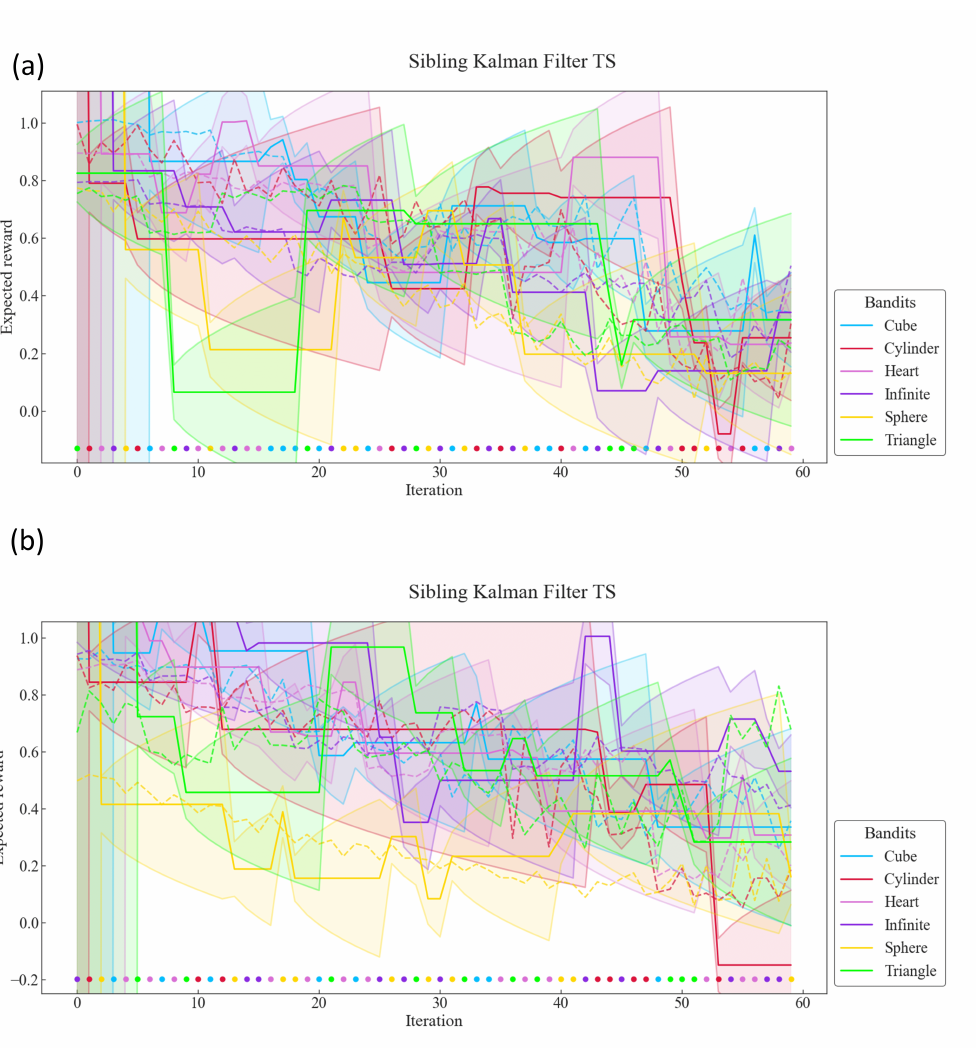
Figure 6. MAB results for UAAE ( a ) and for SSAAE ( b ) for the Sibling Kalman Filter with Thomson Sampling for all iterations on one artificial test dataset from the database XYR. The colored area represents the uncertainty ˆ σ k ( t ) 2 about the expected reward ˆ µ